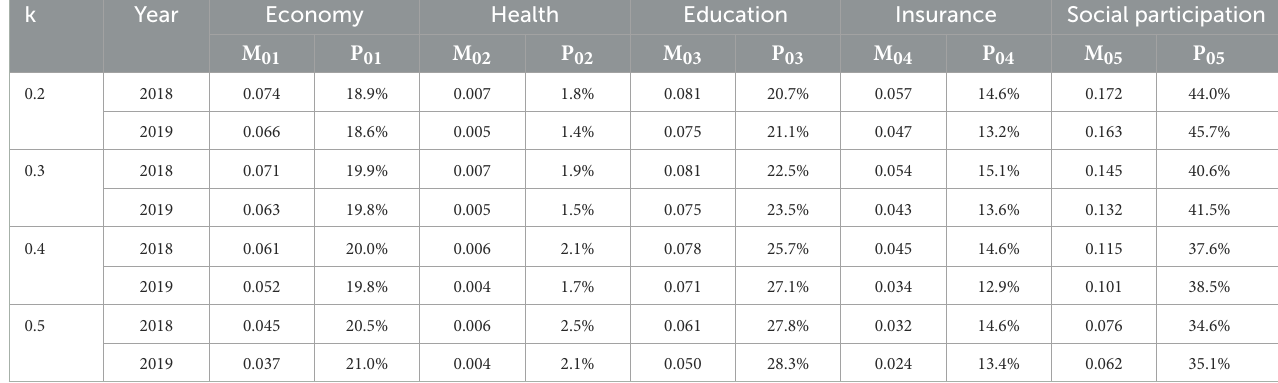
TABLE 3 Decomposition results of MPI for different poverty cutoffs: different dimensions.